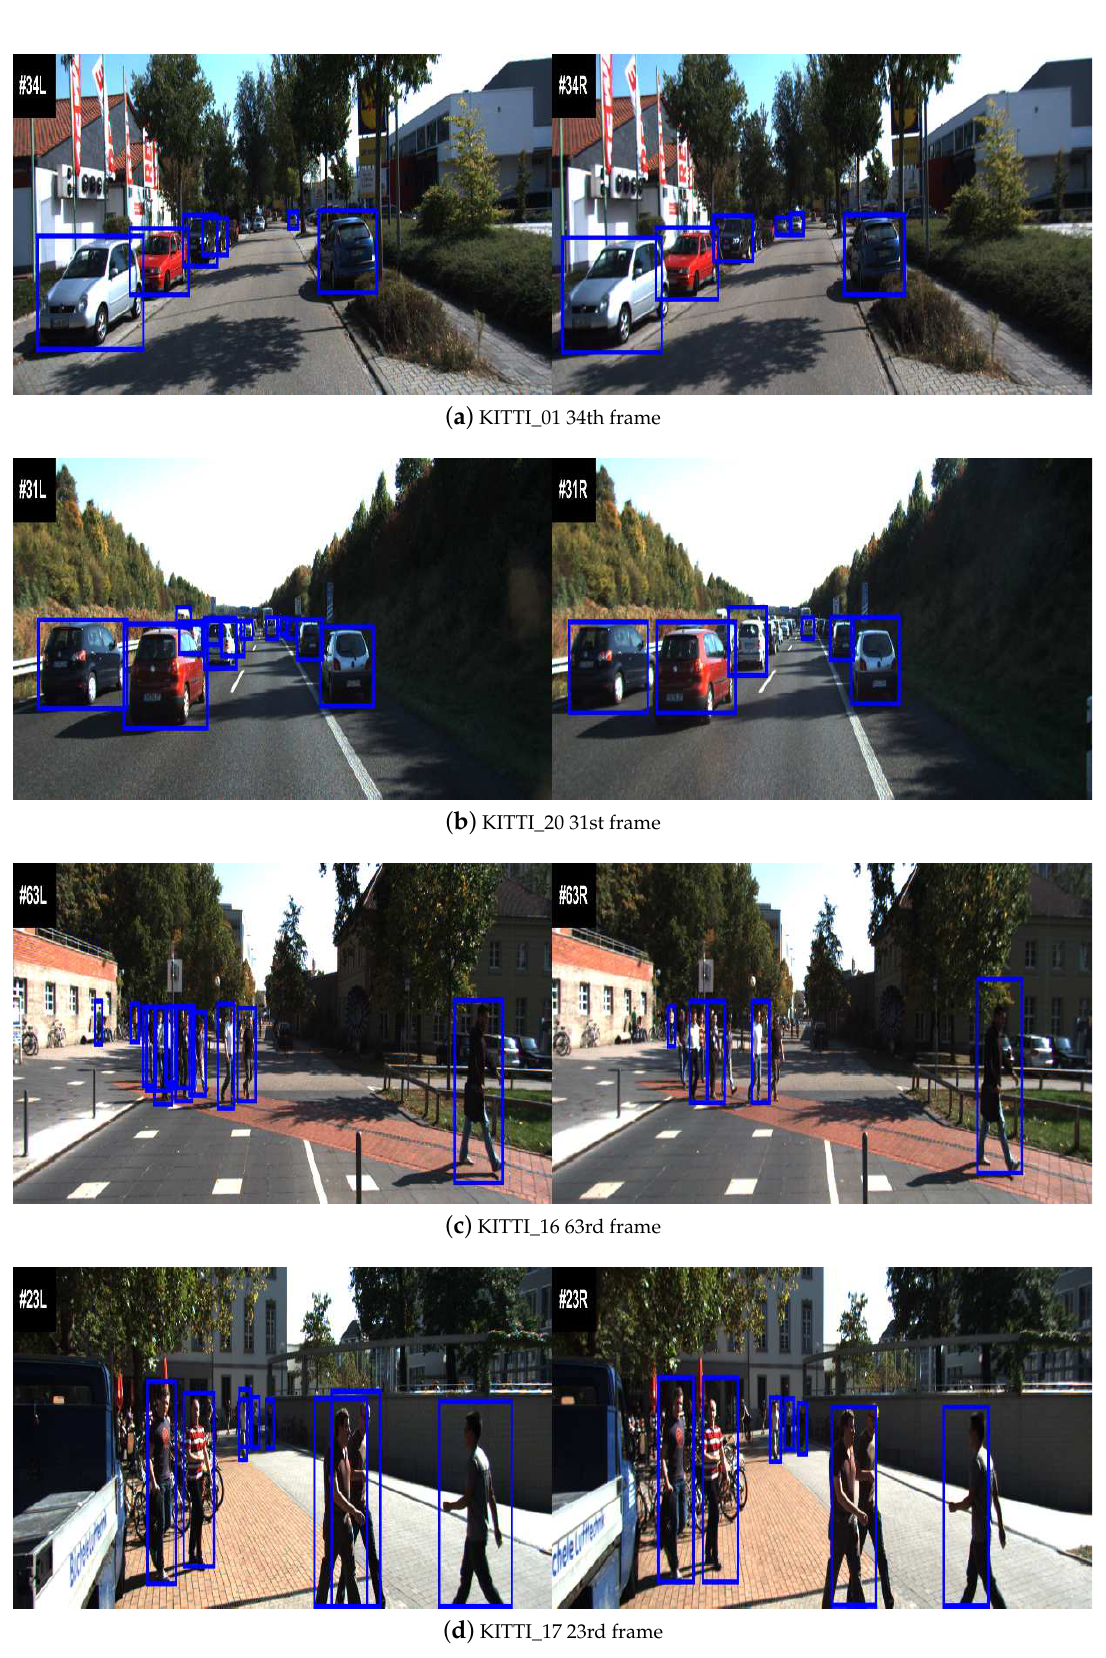
Figure 9. Typical frames of the KITTI dataset [43]. ( a ) Sequence 01 starting frame #34. ( b ) Sequence 20 starting frame #31. ( c ) Sequence 16 starting frame #63. ( d ) Sequence 17 starting frame